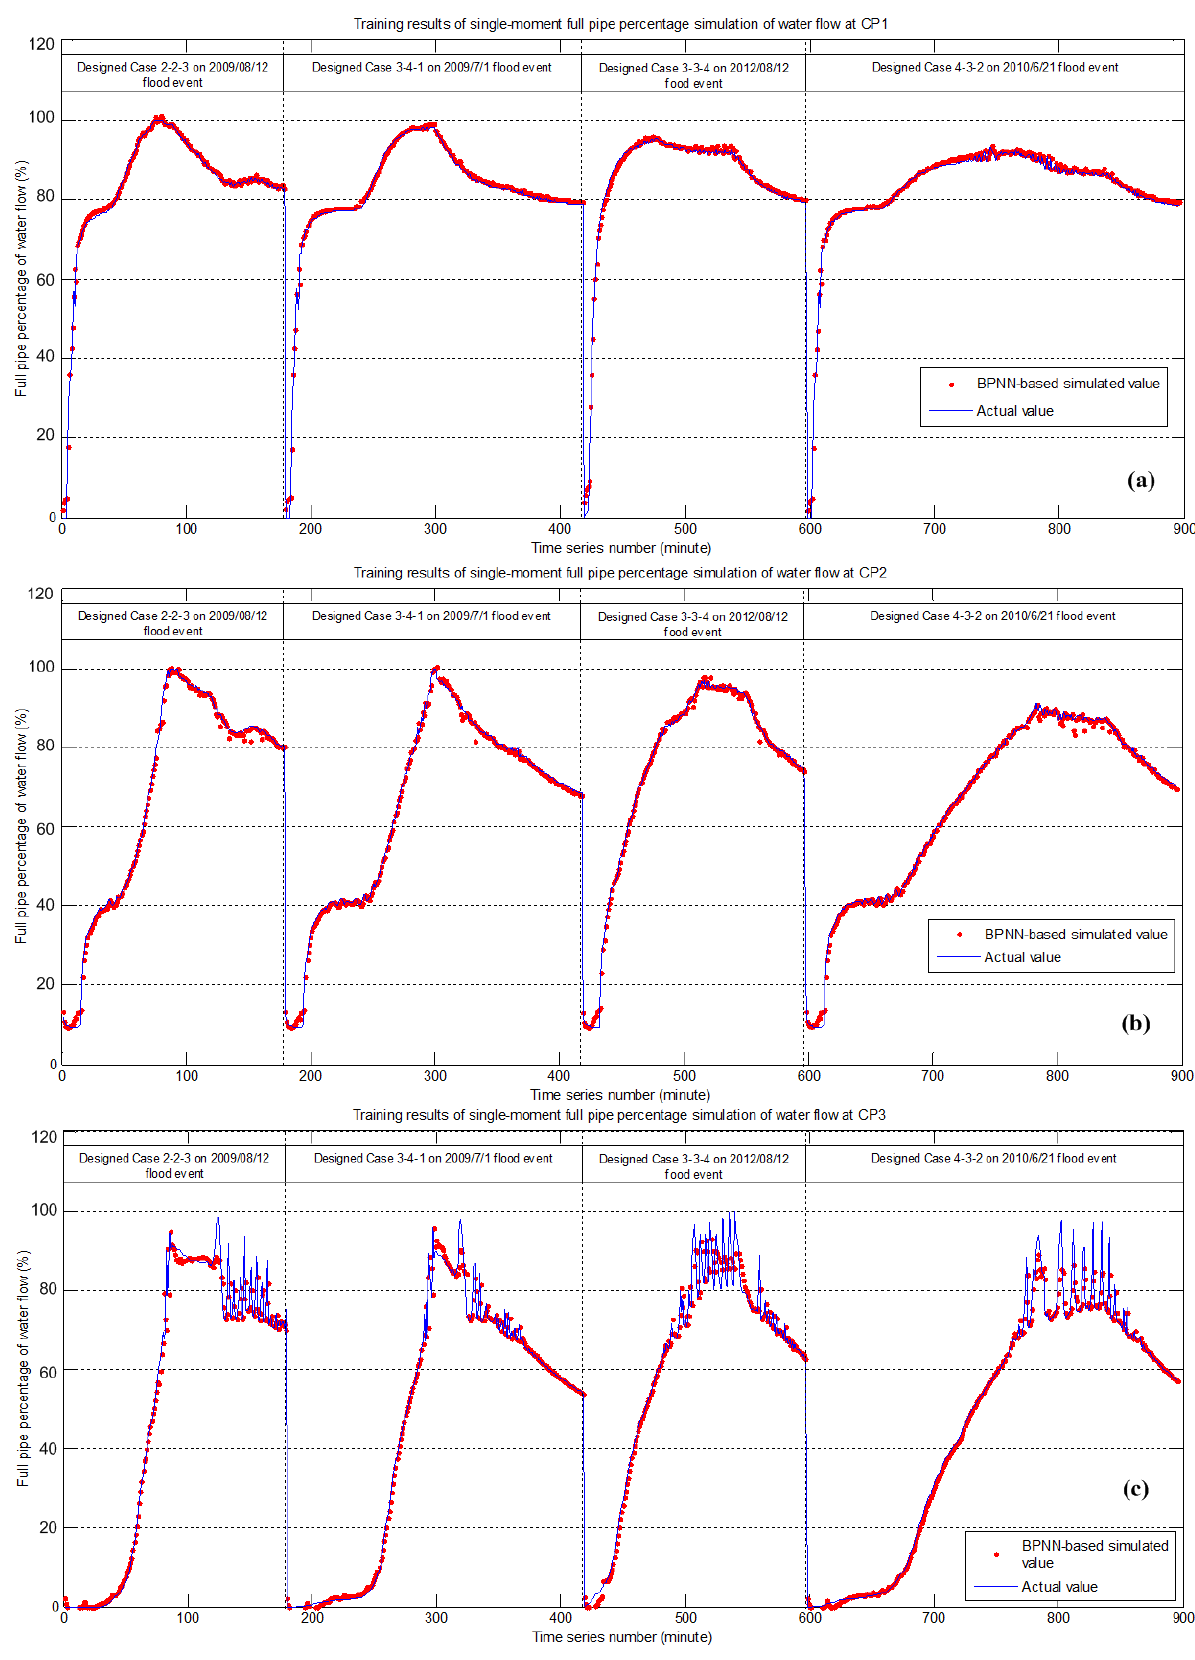
Figure 9. Training results of single-moment full pipe percentage simulation of water flow: ( a ) at CP1; ( b ) at CP2; and ( c ) at